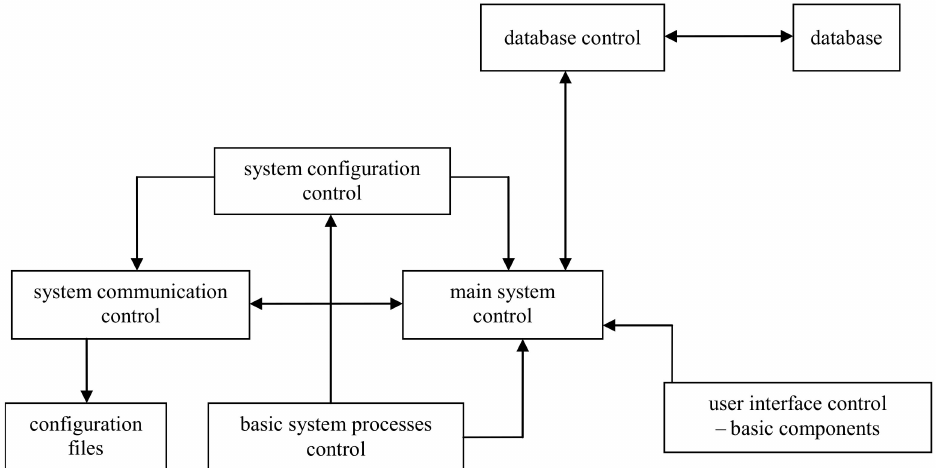
Figure 4. Design of the underground computer together with the database.